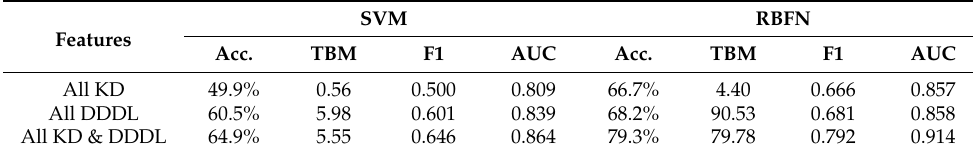
Table 12. Comparison of effectiveness of features by classifier performances.